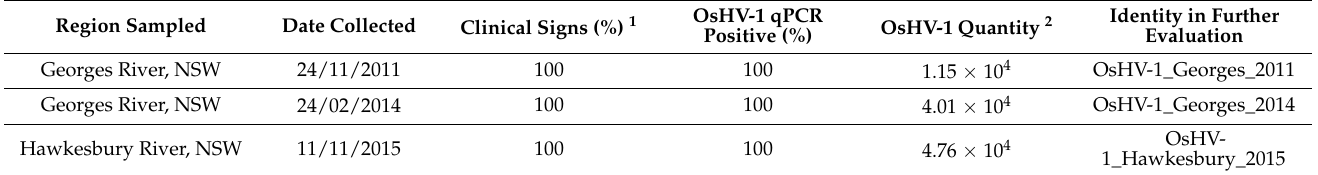
Table 1. Archived oyster tissue samples ( − 80 ◦ C) collected in the field from which primary inoculae (clarified and filtered mantle and gill homogenates) were prepared for injection of naïve Pacific oysters ( n = 8 per group). These experimentally infected oysters provided the first in vivo passage OsHV-1 (secondary inoculae) used to compare the isolates. Region